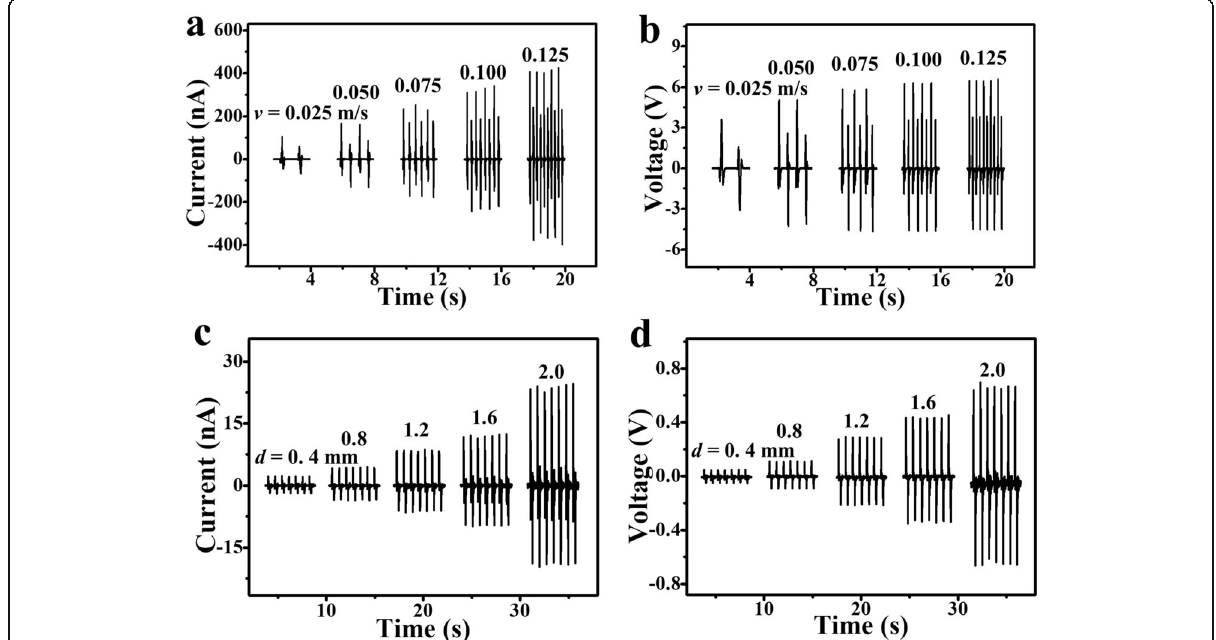
Fig. 3 Power generation performance of the 2DW-WTNG under different relative sliding speeds and relative sliding displacements. a Output current and b output voltage of the 2DW-WTNG varied with the sliding speeds of 0.025 m/s, 0.050 m/s, 0.075 m/s, 0.100 m/s, and 0.125 m/s at a given sliding displacement of 8 mm. c Output current and d output voltage of the 2DW-WTNG varied with the sliding displacements of 0.4 mm, 0.8 mm, 1.2 mm, 1.6 mm, and 2.0 mm at a given sliding speed of 0.100